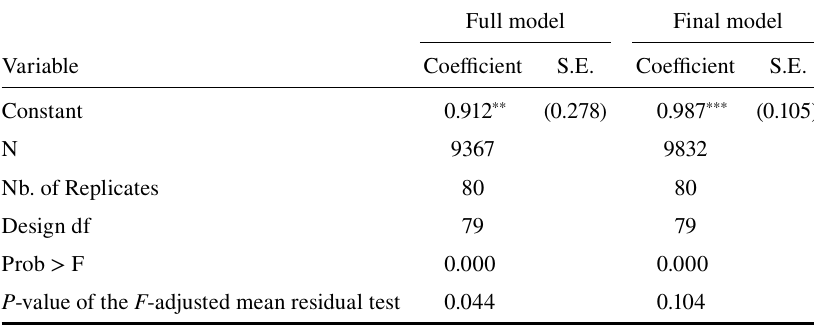
Table 2 Logistic regression models predicting response